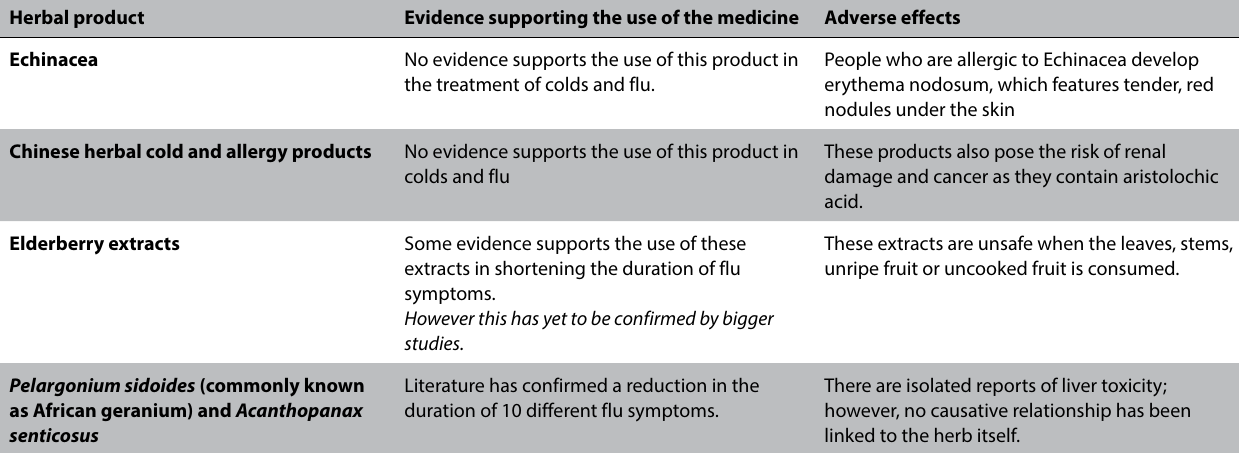
Table 2: Herbal products and supplements 1, 11 . Herbal product Evidence supporting the use of the medicine